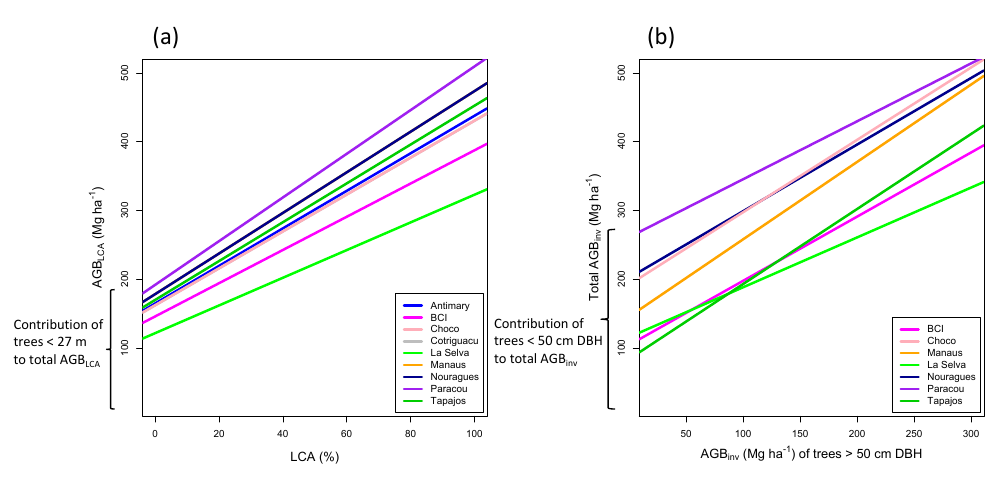
Figure 7. Relationship between LCA and AGB LCA (a) and relationship between AGB inv of large trees ( > 50cm DBH) and total AGB inv (b) . In both cases, the intercepts represent the contribution of small trees to total AGB. Note that Manaus and Nouragues overlap because they have the same mean wood density (WD), as well as Chocó and